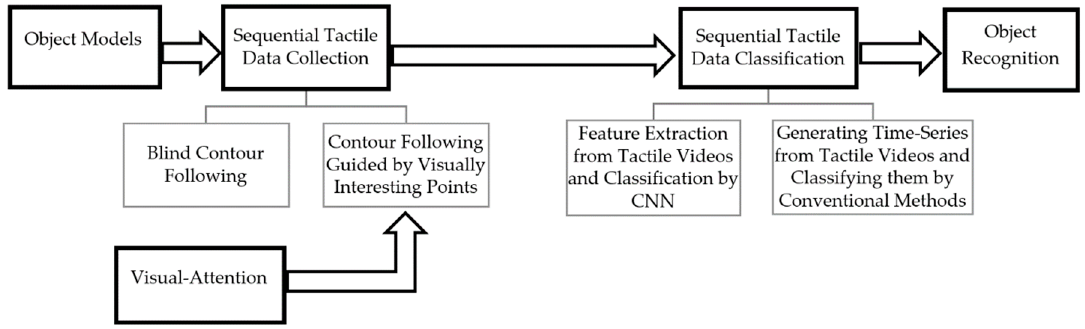
Figure 1. Framework for sequential tactile object recognition.